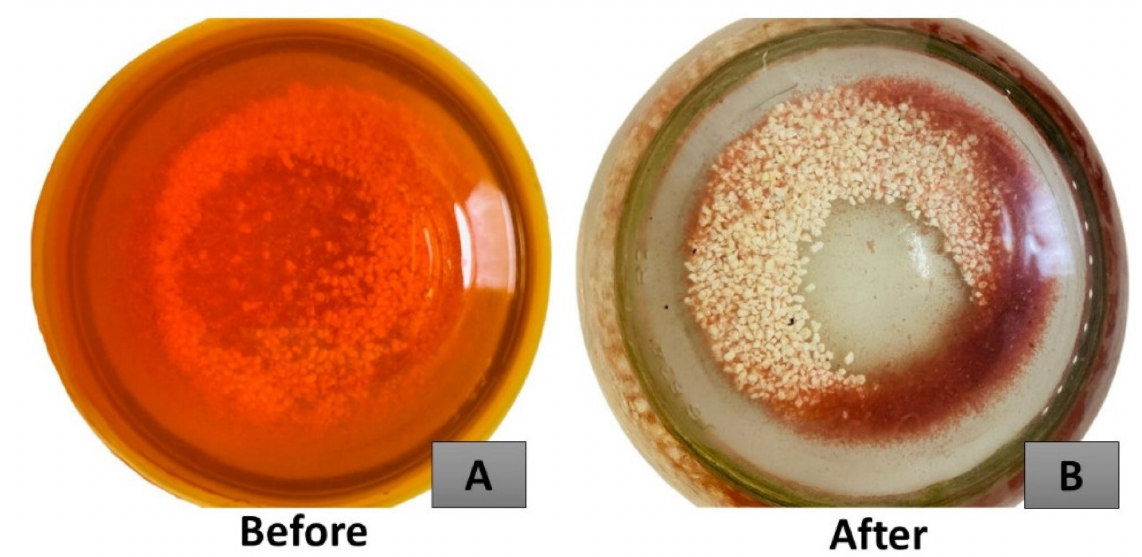
Figure 13. The textile dye wastewater before treatment ( A ) and after treatment ( B ).